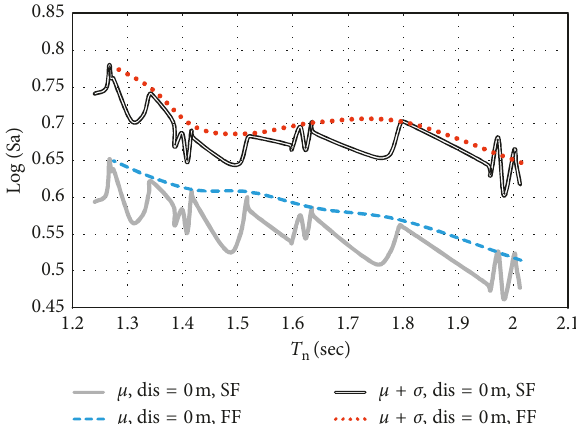
Figure 5: Mean and μ + σ for log of the spectral acceleration of models in the presence (SF) and absence (FF) of a tunnel as determined from the center of the tunnel projection onto the ground surface.